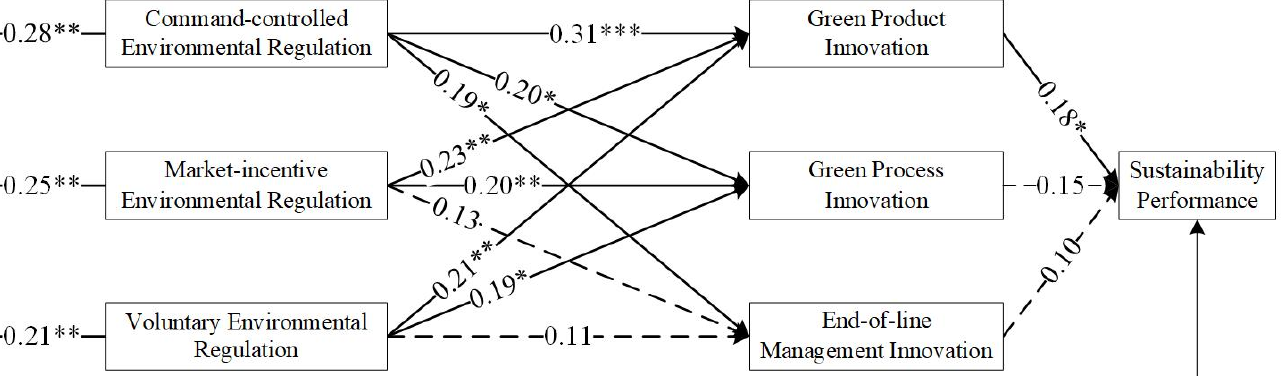
Figure 5. Results of the hypothesized model in West China. * denotes p < 0.05; ** denotes p < 0.01; *** denotes p < 0.001. In this study, the self-help sampling method (bootstrap method) was used to further test for mediating effects (N = 400), and Bias correction was used to detect confidence intervals (see Table 6). Table 6. Indirect effects of environmental regulations on sustainability performance through green technology innovation.